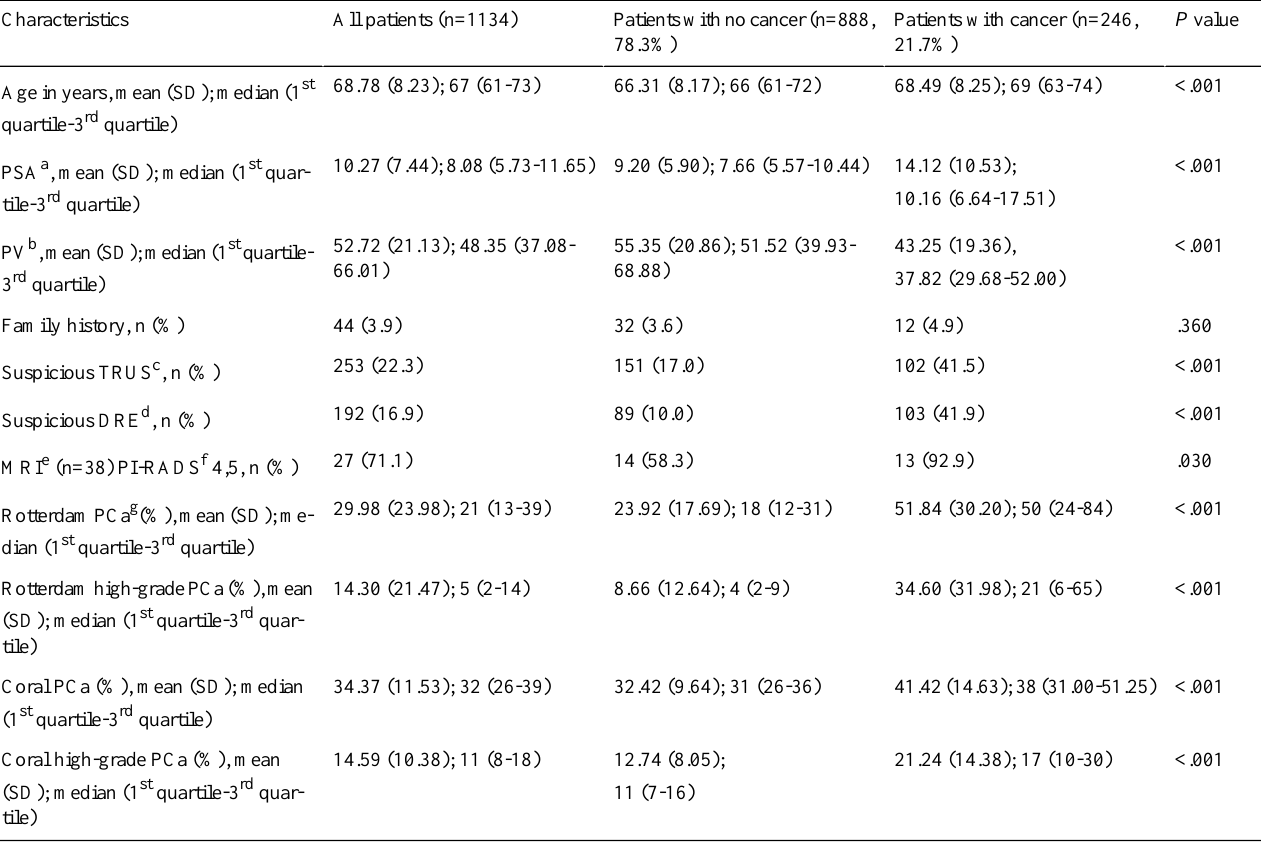
Table 1. Patient demographics (N=1344). Categorical variables were assessed with the chi-square test; continuous variables were compared by the Mann-Whitney U test or the Student independent t test based on their nonnormal or normal distribution, respectively.